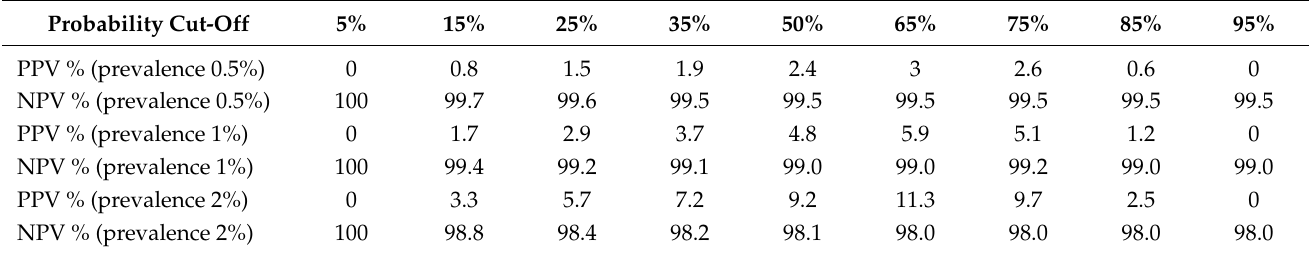
Table 5. Positive predictive value (PPV) and negative predictive value (NPV) of the model at population prevalence 0.5%, 1% and